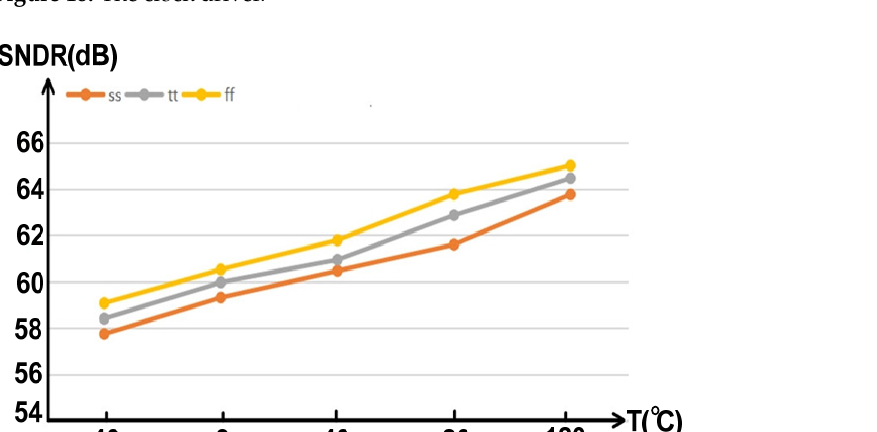
Figure 19. Post simulation results of SNDR with temperature and corner .